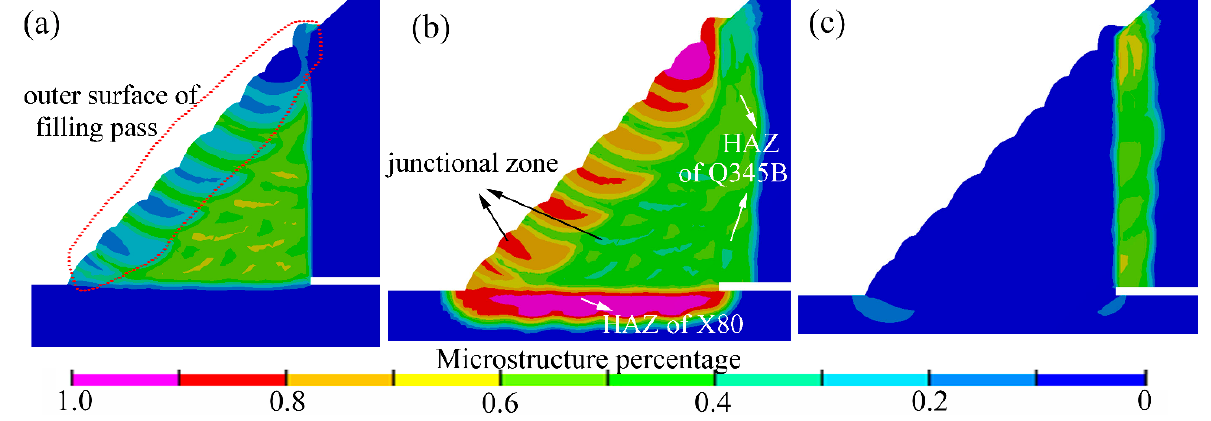
Figure 11. Numerical microstructure distribution contour: ( a ) ferrite, ( b ) bainite, ( c ) martensite.